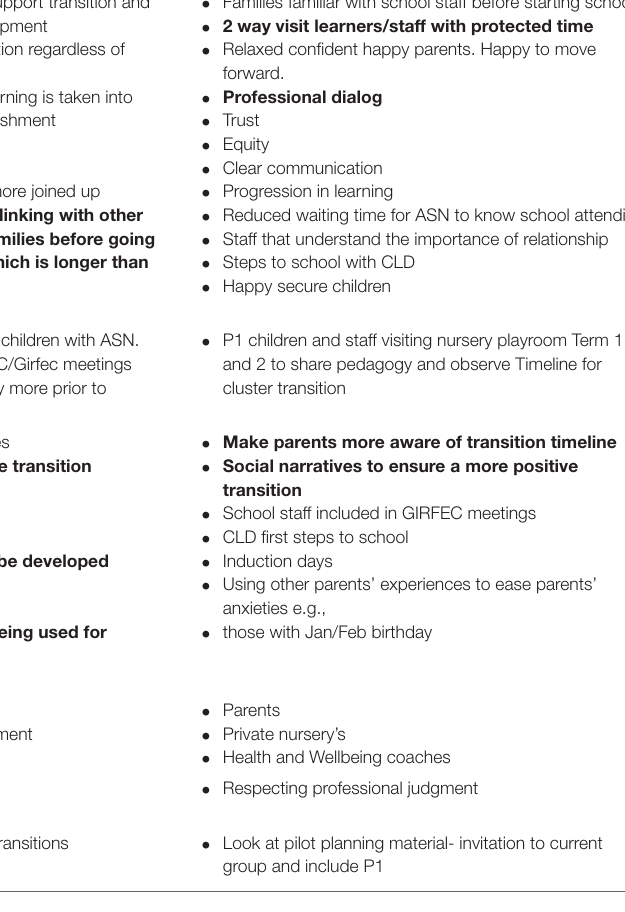
TABLE 1 | PCP themes. Dream Phase Reoccurring themes (mentioned 3 + times) were coded in